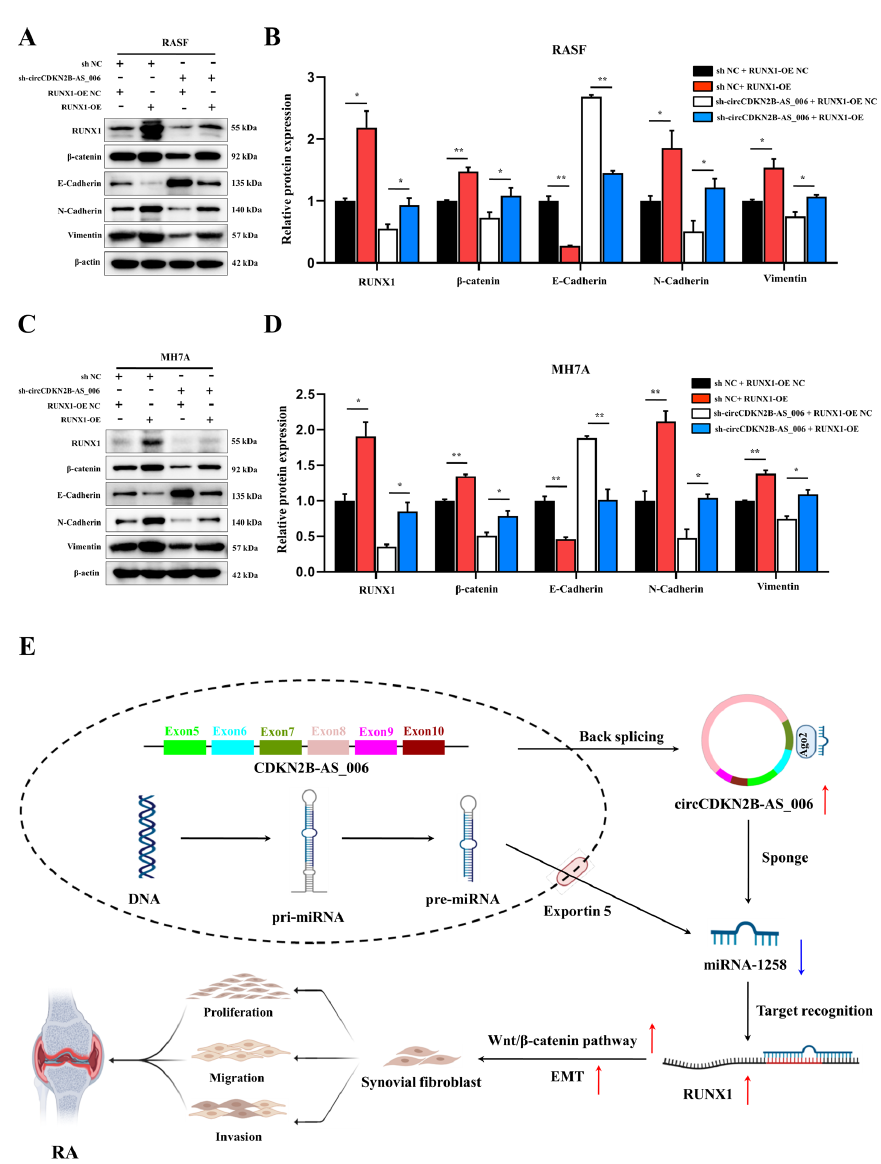
Figure 7. RUNX1 promotes EMT and enhances Wnt/ β − catenin pathway activation. ( A , B ) RUNX1, β − catenin, and EMT − related protein expression was analyzed in RASFs after transfection with sh − circCDKN2B − AS_006 and RUNX1 − OE. ( C , D ) RUNX1, β − catenin, and EMT − related protein expression was analyzed in MH7A cells after transfection with sh − circCDKN2B − AS_006 and RUNX1 − OE. ( E ) Schematic diagram illustrating the mechanism by which circCDKN2B − AS_006 promotes RASF proliferation, migration, and invasion through miR − 1258/Wnt/ β − catenin pathway and EMT axis. ** p < 0.01, * p < 0.05.